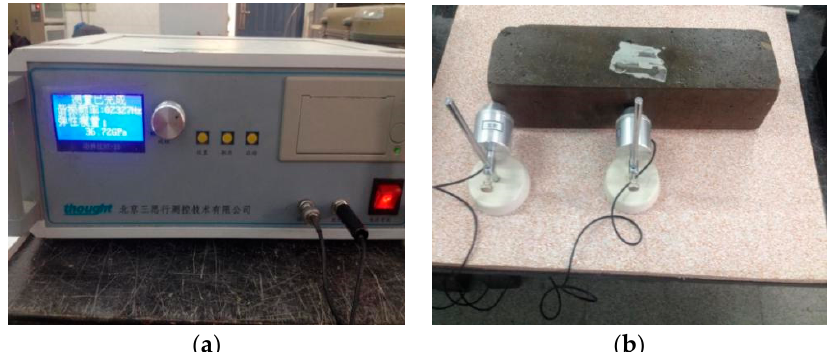
Figure 4. ( a )Transverse fundamental frequency measurement and ( b ) position of measuring point after freeze–thaw cycle.